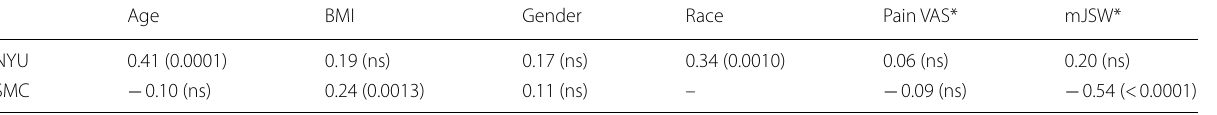
Data are shown as partial r ( p value), where non-significant (ns) is p > 0.1